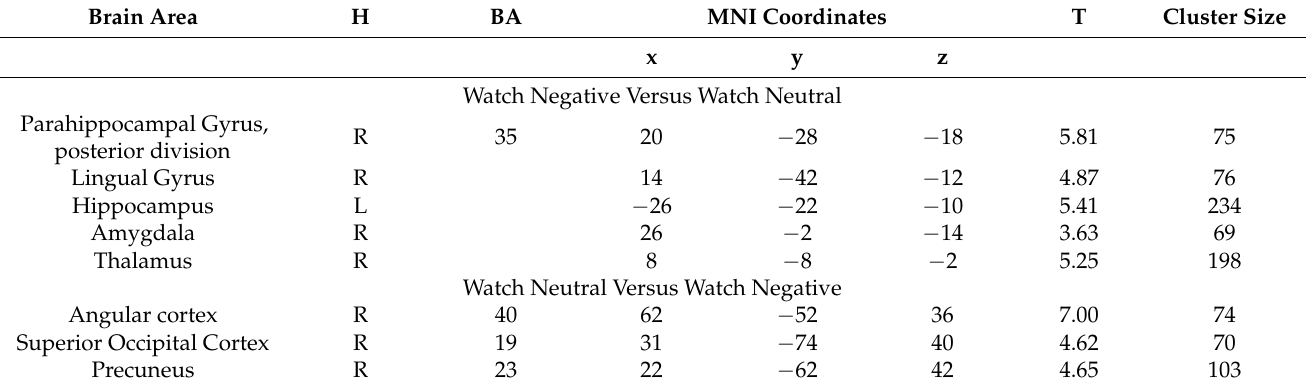
Table 3. Activations for emotional versus neutral pictures in the watch